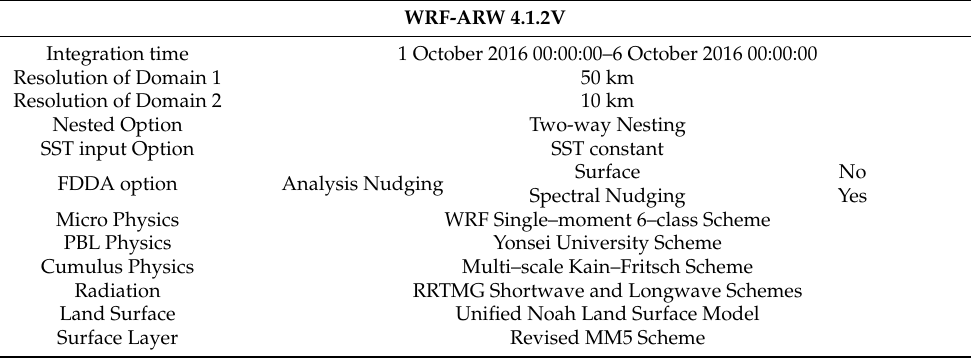
Table 1. The integration time, resolution, and options of WRF-ARW 4.1.2V simulation.